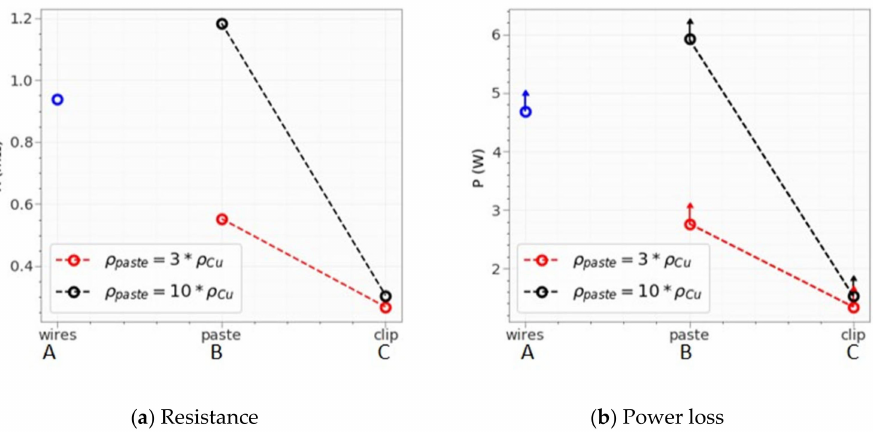
Figure 8. Electrical simulation results of the ideal performances of the three structures in high-current regimes ( a , b ). The red lines refer to ρ CuPaste = 3 × ρ Cu and the black lines to ρ CuPaste = 10 × ρ Cu for a fixed t CuClip = 100 µ m. Arrows in panel ( b ) show the maximum expected contribution at f = 100 kHz of eddy current effects on the power